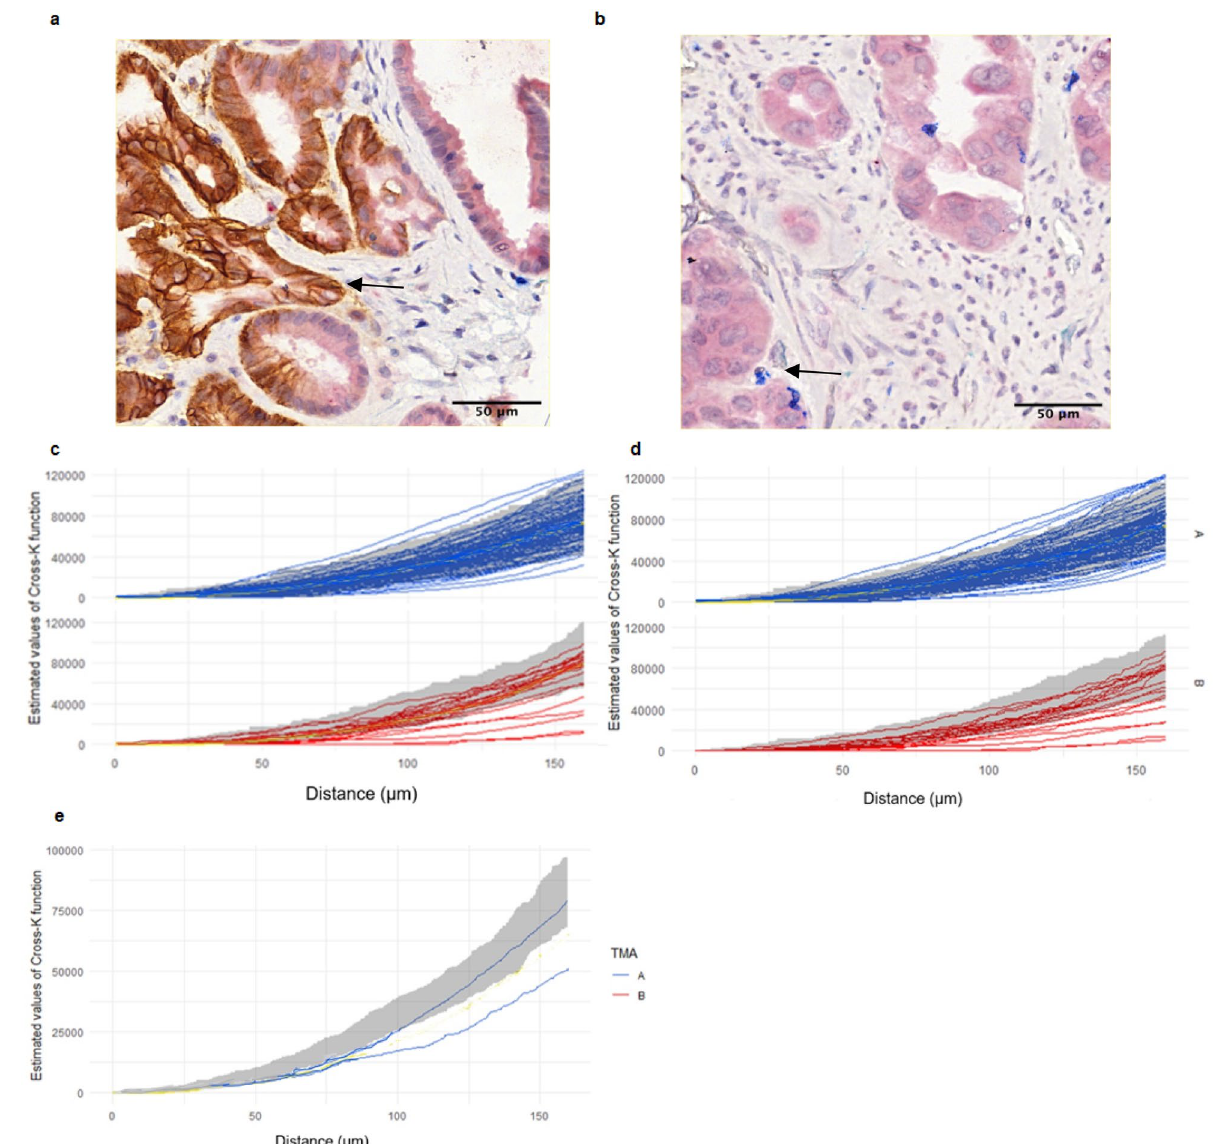
Figure 2. Staining images of CAIX and CD8 + and estimated cross-K functions of CAIX and CD8 + T cells with aggregate envelopes (gray area) from simulations by TMA and tissues. ( a ) Representative staining image of CAIX in brown. ( b ) Representative staining image of CD8 + in blue. ( c ) Cross-K functions plot for all COEUR. ( d ) Cross-K functions plot for stroma tissue, negative spatial association observed in TMA B, as shown in the plot 7 estimated cross-K functions (red lines) below the envelope. ( e ) Cross-K functions plot for tumor tissue, estimated cross-K functions not displayed for the density of CAIX and CD8 + below the threshold.